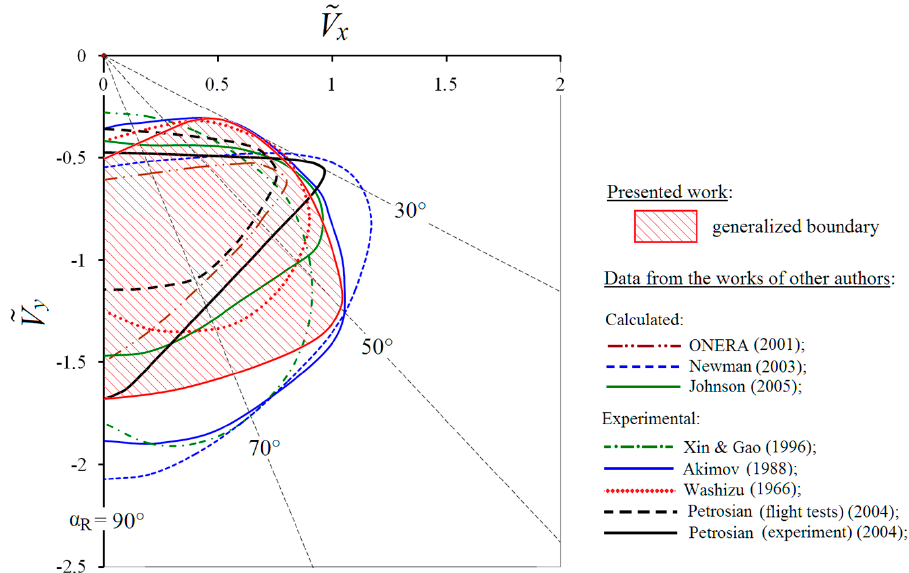
Figure 18. Comparison of the calculated generalized boundary of the VRS modes (see Figure 17) with the experimental [6,7,12,13] and calculated [8,21] boundaries of other authors.